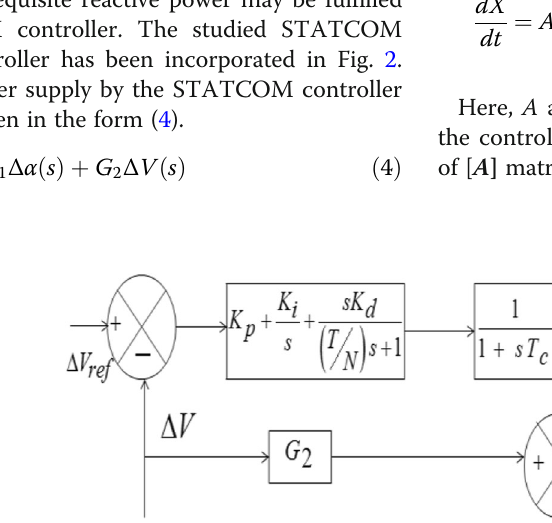
The state space model of the complex dynamic linear system may be represented as in (5). dX